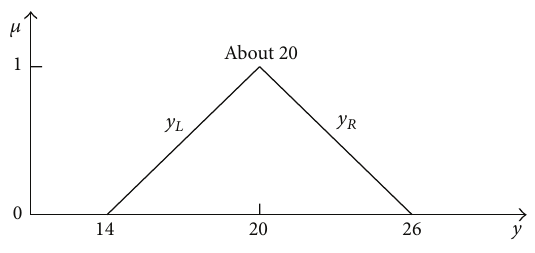
Figure 18: 2D representation of the full 4D result (59) 𝑦 = ,𝛼 ) of the addition of two fully dependent fuzzy numbers 𝑓(𝜇,𝛼 𝑥 1 𝑥 2 “about 10” + “about 10” satisfying the condition 𝛼 𝑥